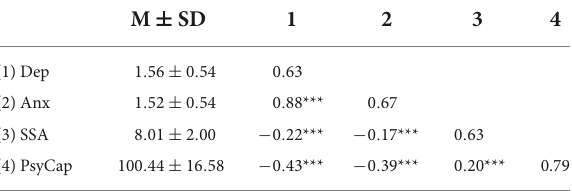
TABLE 1 Descriptive statistics and bivariate